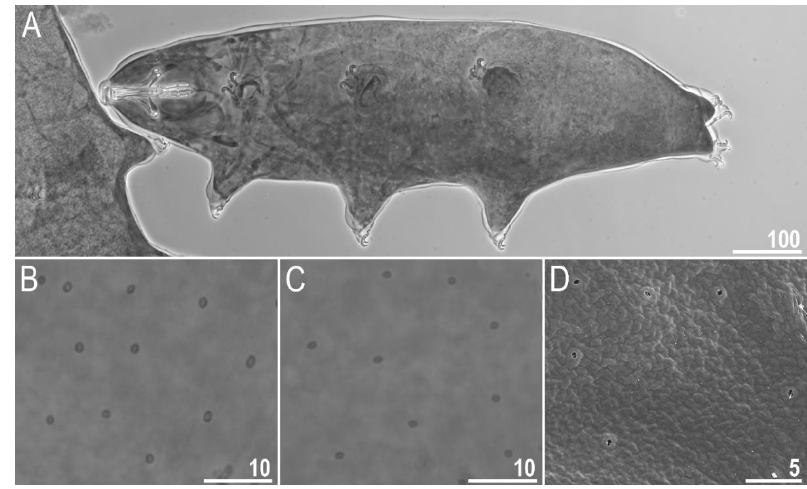
Figure 1. Macrobiotus rebecchii sp. nov. — images of habitus and cuticular pore: ( A ) dorso-ventral projection (holotype, PCM); ( B ) pores in the dorsal cuticle (paratype, PCM); ( C ) pores in the ventral cuticle (paratype, PCM); ( D ) pores in the dorsal cuticle (paratype, SEM). Panel D also shows minute granulation that is not visible in PCM (the same as in Figure 3F) but here it can hardly be discriminated from dirt, which is also present on this fragment of the dorsal cuticle. Scale bars in μm.